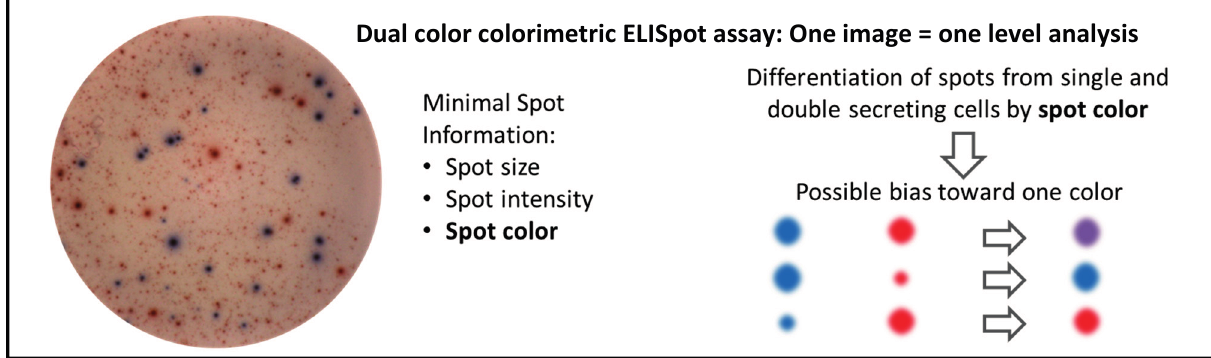
Figure 1. Color bias in colorimetric dual color ELISpot assay. Evaluation of enzymatic dual color ELISpot assays is solely based on spot color, with single cytokine spots being red or blue, and dual cytokine spots theoretically purple. Dual spots with high intensity in only one color risk being misinterpreted as single spots as the stronger spot will obscures the weaker one. This will result in an underestimate of the number of dual secreting cells as well as an underestimate of the total number of spots for the weaker color. Dual color colorimetric ELISpot assay: One image = one level